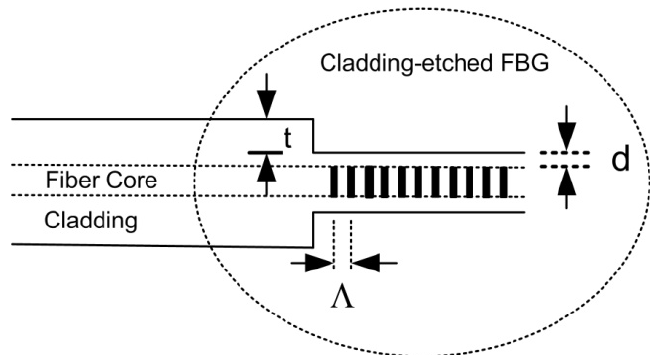
Figure 1. Structure of the cladding-etched